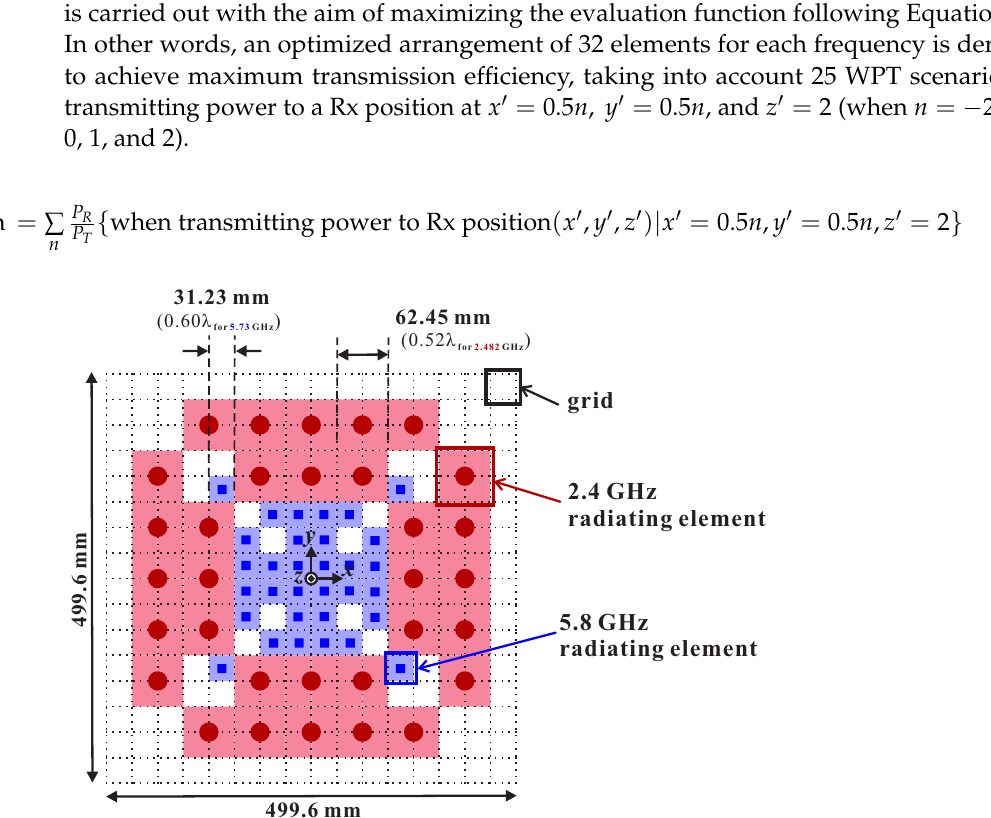
Figure 2. Arrangement of radiating elements in the optimized shared-aperture dual-band